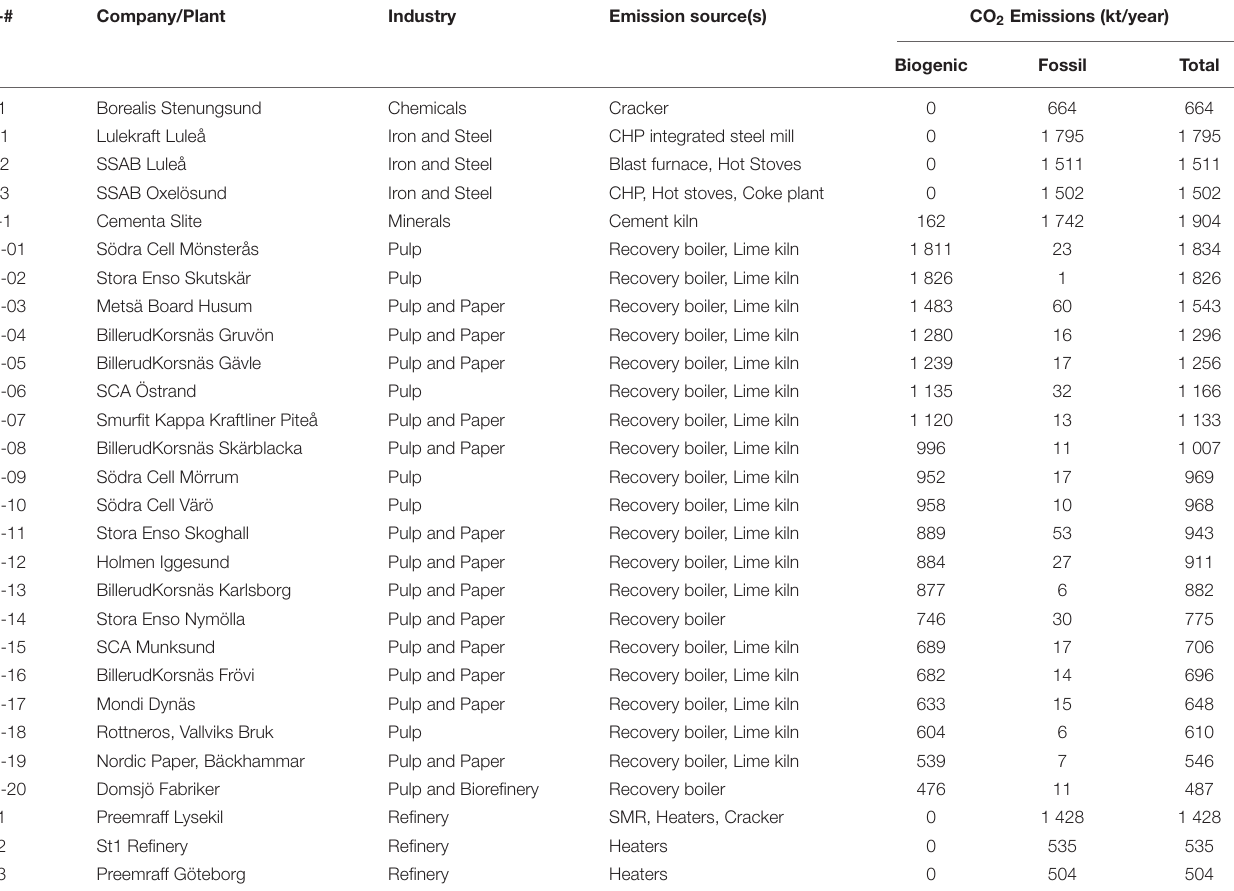
TABLE 3 | Industrial plants considered in the study, i.e., all Swedish industrial plants with annual CO 2 emissions of 500 kt or more (Year 2016